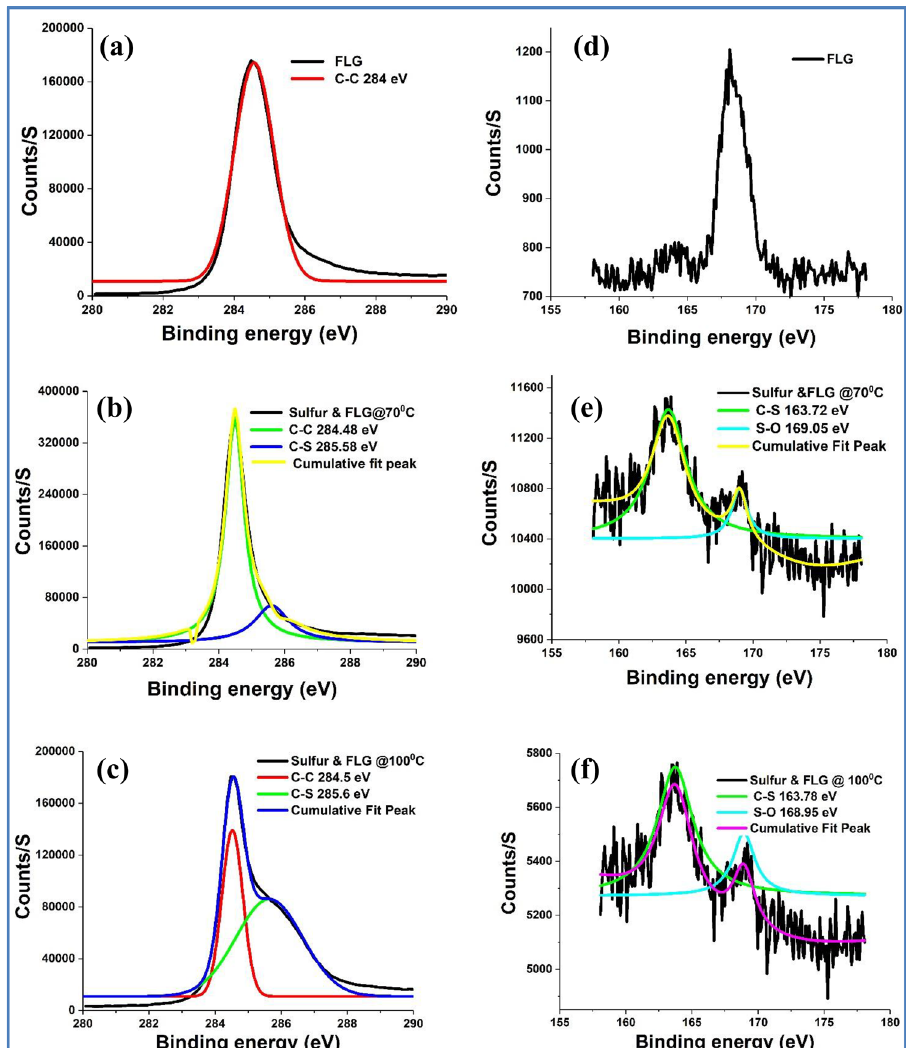
Figure 4. XPS spectra for C1s for ( a ) FLG ( b ) control experiments (FLG and sulfur) performed at 70 °C and ( c ) 100 °C. S2p spectra for ( d ) FLG and ( e ) control experiments (FLG and sulfur) performed at 70 °C and ( f ) 100